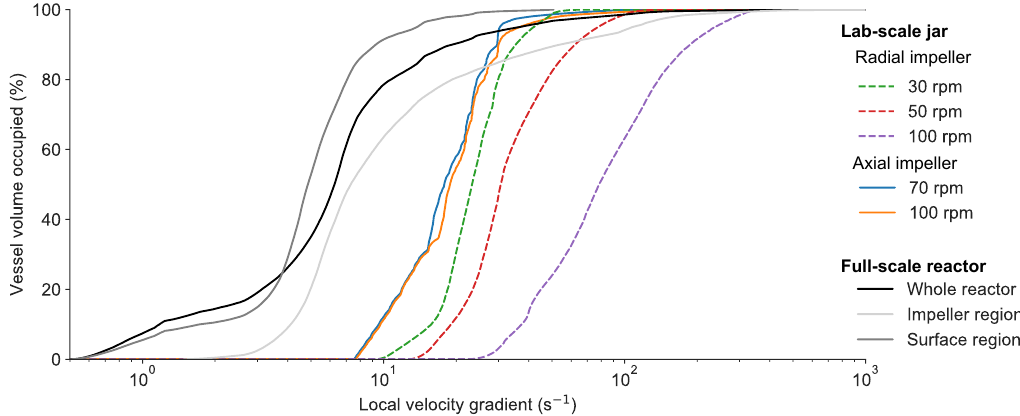
Figure 9. Cumulative volume (%) distribution of the local velocity gradients ( G loc ) in the lab scale jar and in the first part (anoxic section) of the full scale HRAS system at the WRRF